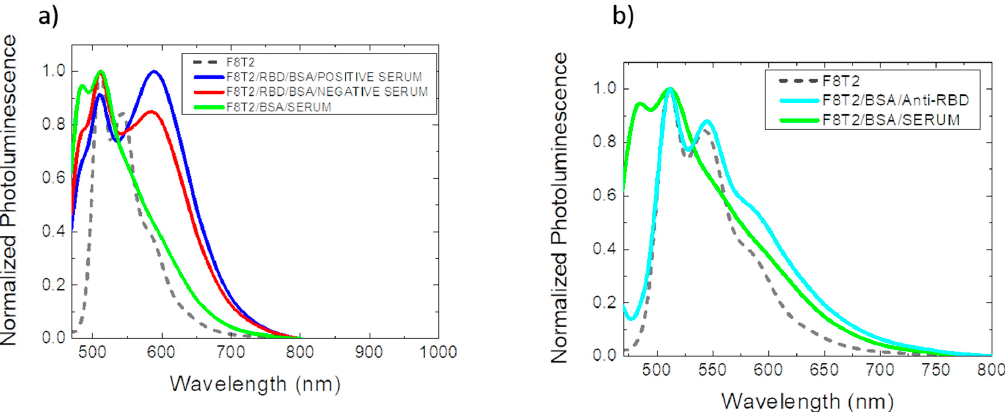
Figure 5. ( a ) Normalized photoluminescence spectrum of the optical biosensor using blood serum for the detection of COVID-19; ( b ) Normalized photoluminescence spectrum of the interaction of anti-RBD with F8T2 and the interaction between blood serum and F8T2.